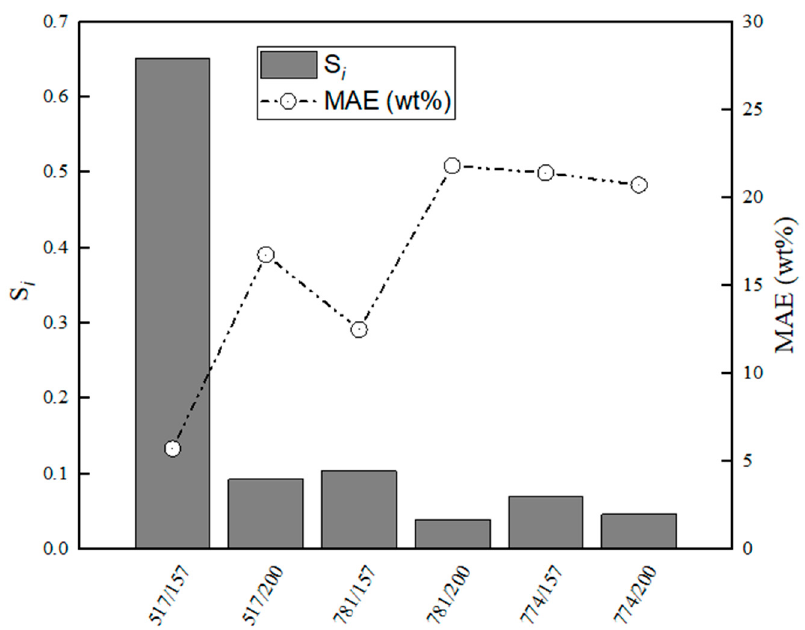
Figure 13. Evaluation of relative stabilities (Si) of the calibration variable candidates and mean absolute error values obtained for training and validation sets for C12A7–CaS.